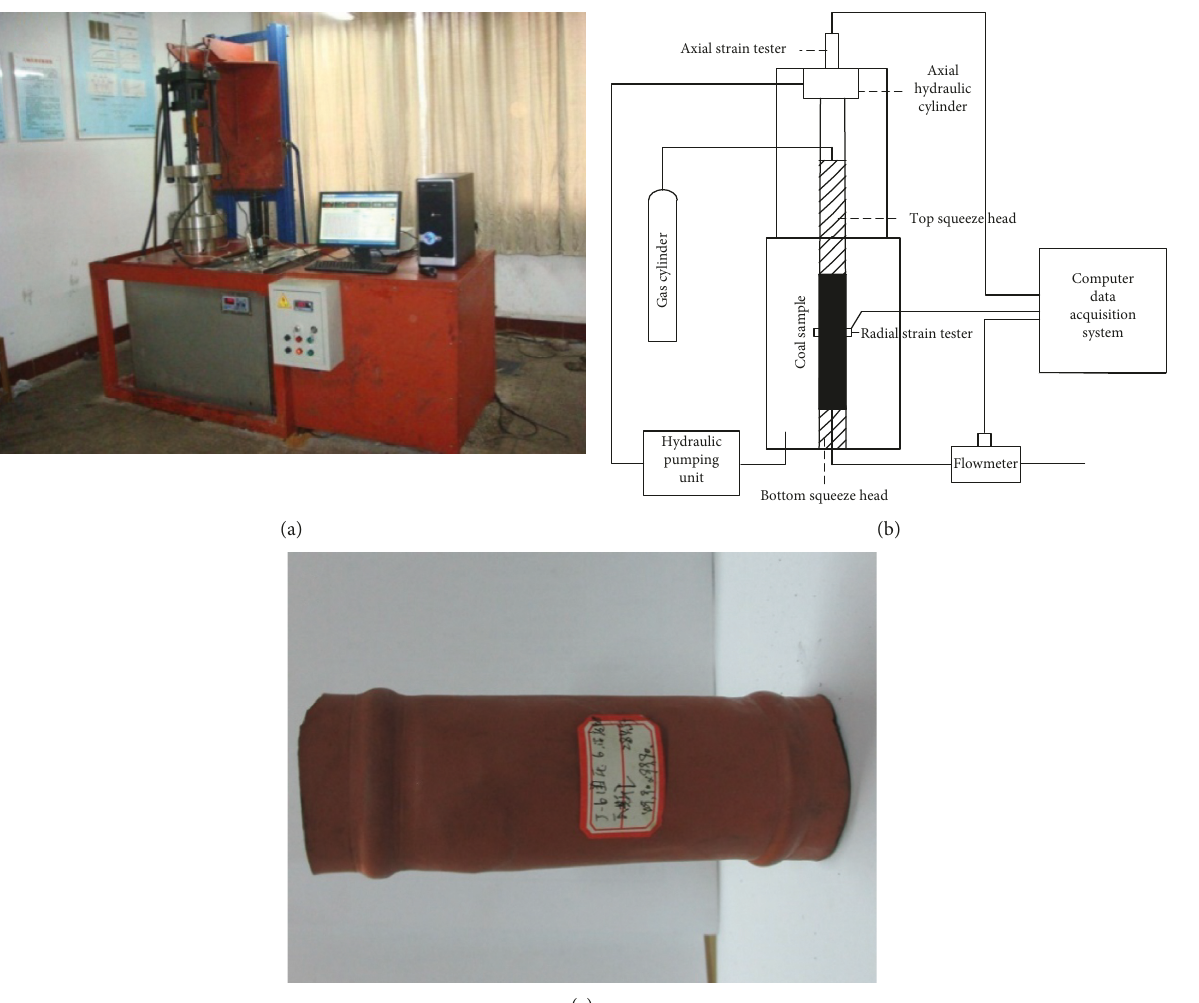
Figure 2: (a) Heat-solid-fluid coupling triaxial seepage device, (b) experimental workflow, and (c) coal